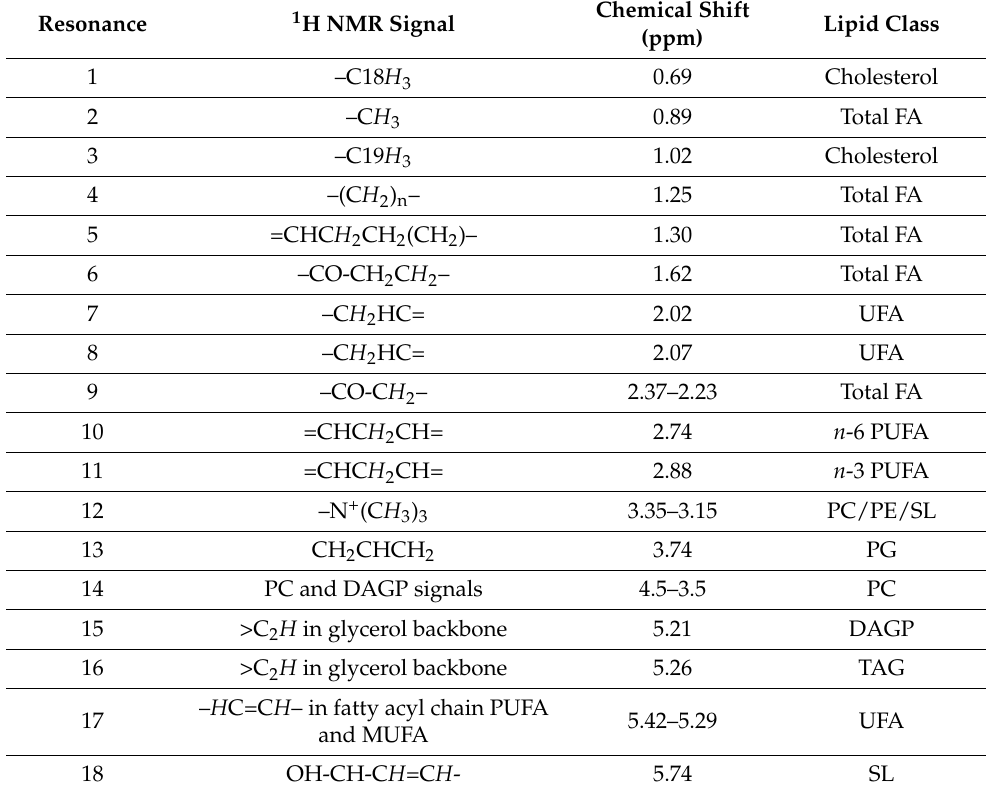
Table 1. Different lipid classes, with the corresponding resonance assignments, were identified by the NMR analysis. DAGP = diacylglycerophospholipids; FA = fatty acid chain; MUFA = monounsat- urated fatty acids; SL = sphingolipids; PC = phosphatidylcholine; PG = phosphatidylglycerol; PUFA = polyunsaturated fatty acids; TAG = triacylglycerol; UFA = unsaturated fatty acids.